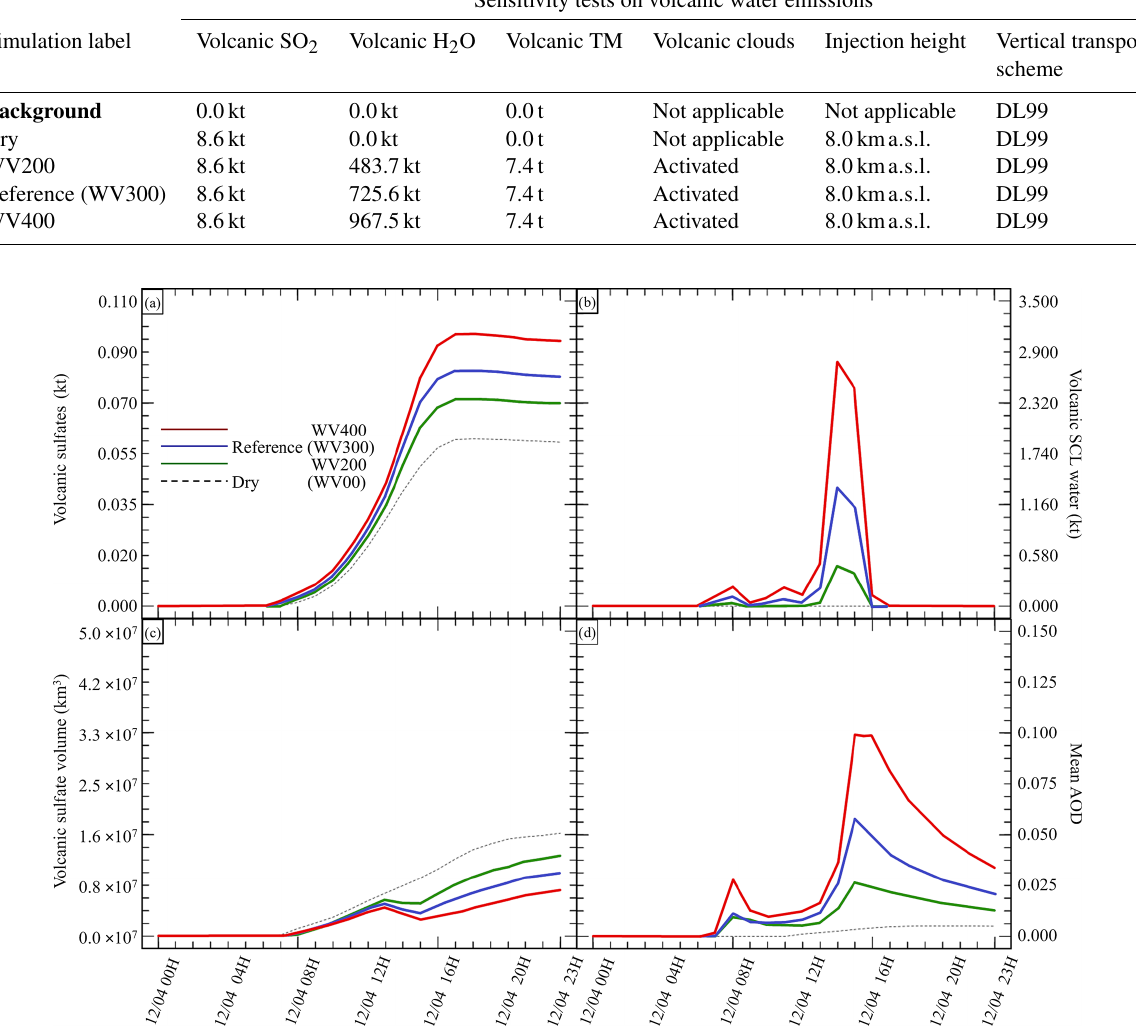
Figure 3. Sensitivity tests on volcanic water emissions for (a) sulfate aerosols (SO 2 volume (km 3 ) ⊂ 25% of SO 2 − mass and (d) the AOD for plume ⊂ 25% of SO 2 − 4(p) case. All time series represent differences relative to the Background simulation (the simulation without volcanic